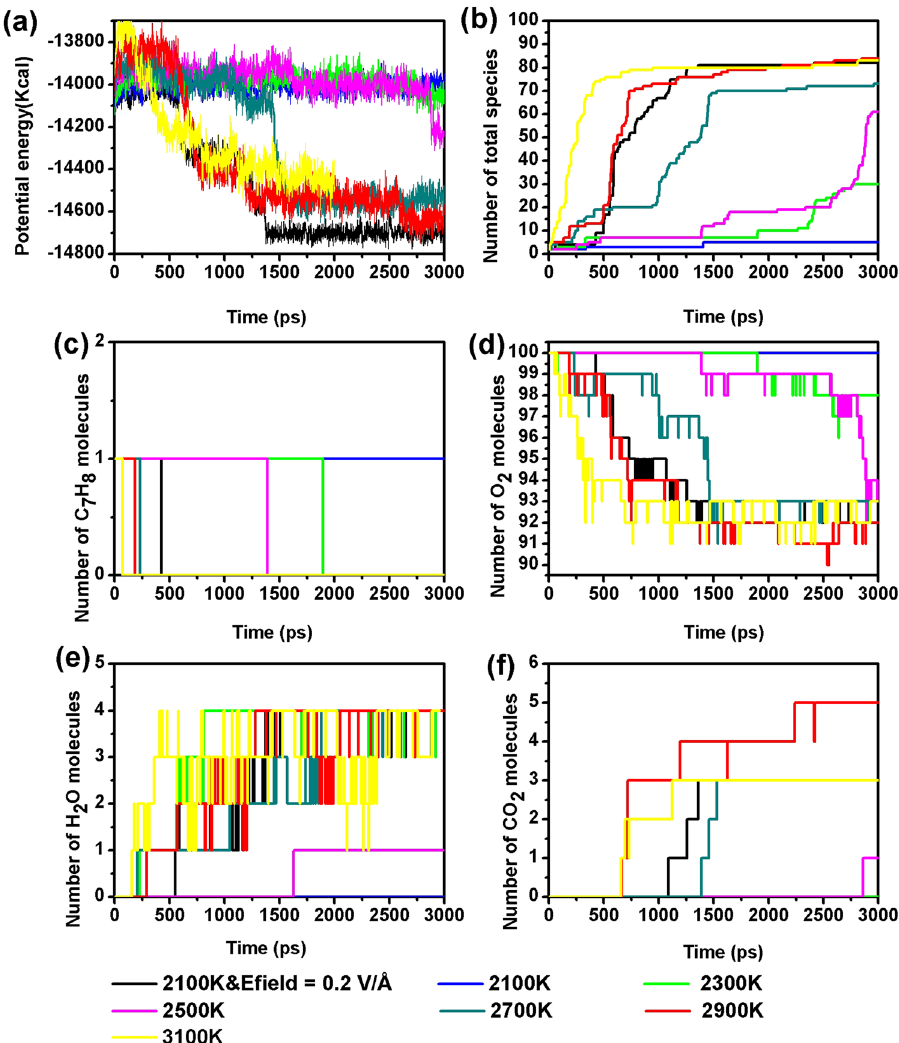
Figure 6. Evolution of the potential energies, total number of species, toluene, oxygen and main products at T = 2100 K, 2300 K, 2500 K, 2700 K, 2900 K, 3100 K as well as T = 2100 K and Efield = 0.2 V/Å (ReaxFF NVT-MD simulation, ρ = 0.35 g/cm 3 , toluene/oxygen =